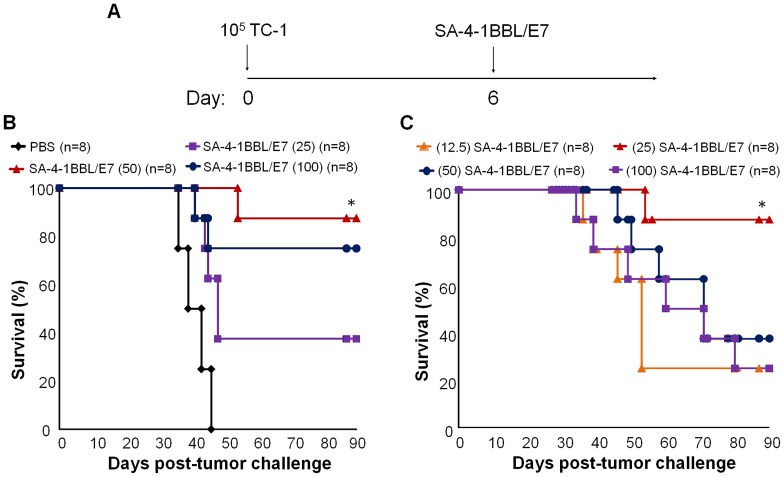
Optimizing the SA-4-1BBL/E7 vaccine formulation for the most effective therapy in the TC-1 cervical cancer mouse model.C57BL/6 mice were inoculated s.c. with 1×105 live TC-1 tumor cells and vaccinated with the indicated doses of E7 and SA-4-1BBL proteins on day 6 post-tumor challenge. Mice vaccinated with PBS were used as controls. (A) Schematic depiction of the experimental procedure. (B) Optimizing the dose of E7 antigen. Mice were vaccinated with the indicated doses of E7 in µg with a fixed amount of SA-4-1BBL (25 μg). *P<0.05 vs. all other groups, except E7 100 µg. (C) Optimizing the dose of SA-4-1BBL. Mice were vaccinated with the indicated doses of SA-4-1BBL with the optimum 50 µg dose of E7 as determined in (B). The 25-μg SA-4-1BBL treatment group was significant (*P<0.05) from all other groups and found to be the optimal dose. The SA-4-1BLL/E7 (25 /50 µg) group from panel A is re-graphed for direct comparison with the other groups.